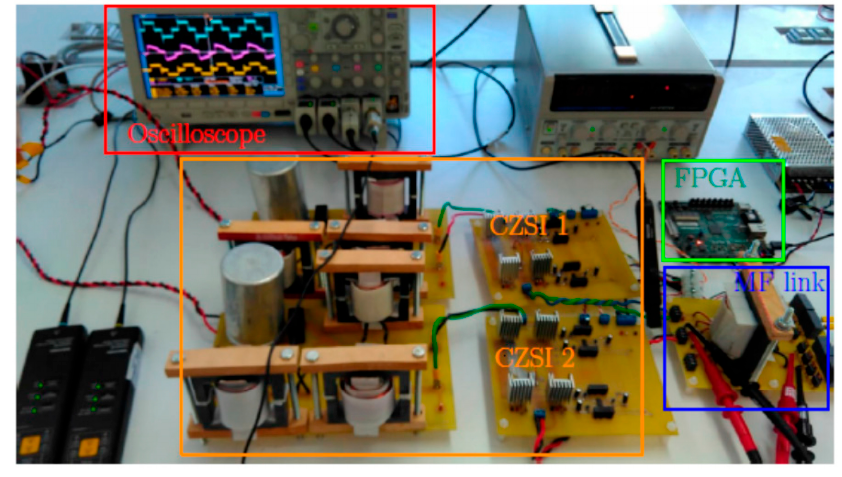
Figure 12. Experimental